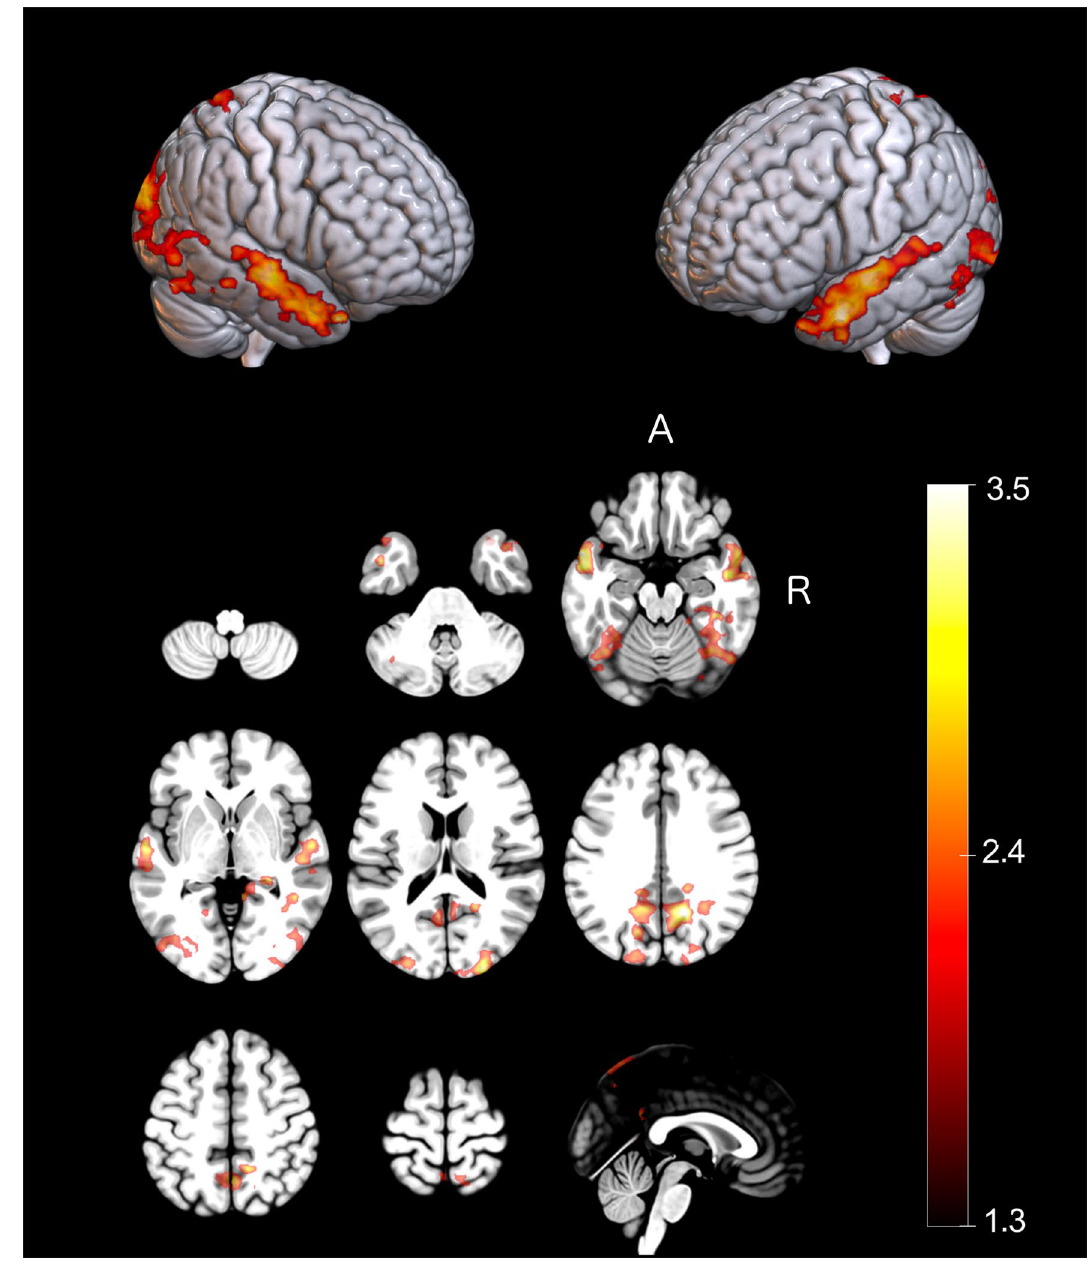
Figure 3. Effects of training on resultant motor imagery-based brain activity where the colourbar represents the Z-max value. Activated voxel clusters remaining after subtraction of the map of activations of post-training scan from the pre-training scan across all participants. Activation was localized to regions including bilateral fusiform gyri, precuneus, middle temporal gyri, and middle occipital gyri. Clusters shown reached a cluster corrected threshold (Z > 2.0; p < 0.05), family-wise error corrected for number of comparisons, and are shown overlaid on the MNI